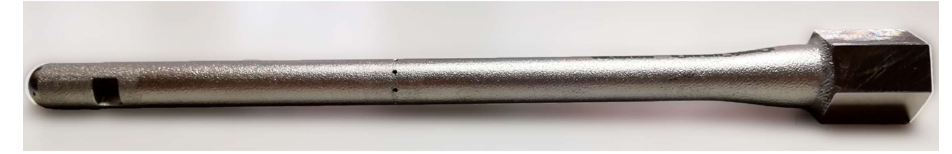
Figure 8. Additive manufactured probe after printing and the side opening to the axial heater cavity.